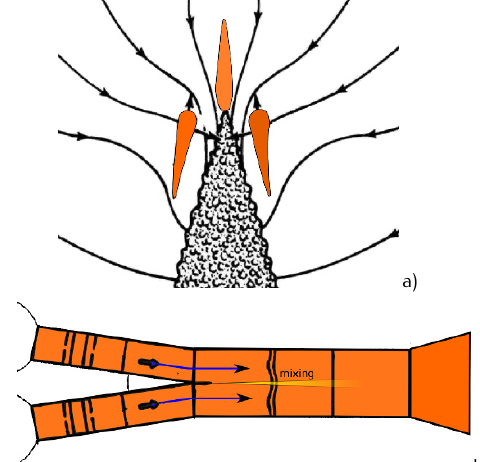
Figure 8. Details affecting the thrust performance of the propulsion nozzle. a) Jet mixing in the region of reduced pressure, at primary nozzle exit, can be used to entrain fluid and in- crease the initial jet thrust, by increasing the accelerated amount of mass. b) A non-adequate treatment of the mix- ing layer, formed when two different mass streams join in- side the HOMER nozzle, can enlarge the losses and re- duce the performance, see also Fig. 5.